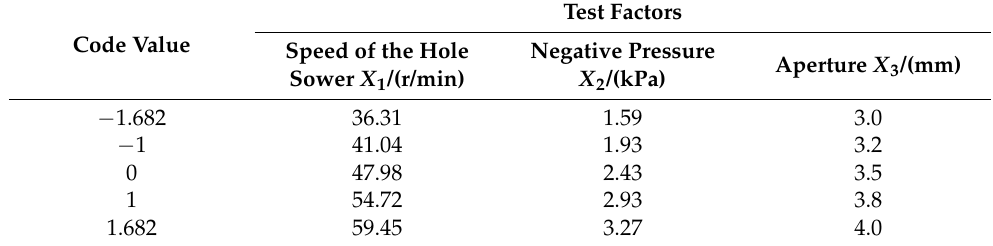
Table 2. Factor level codes.